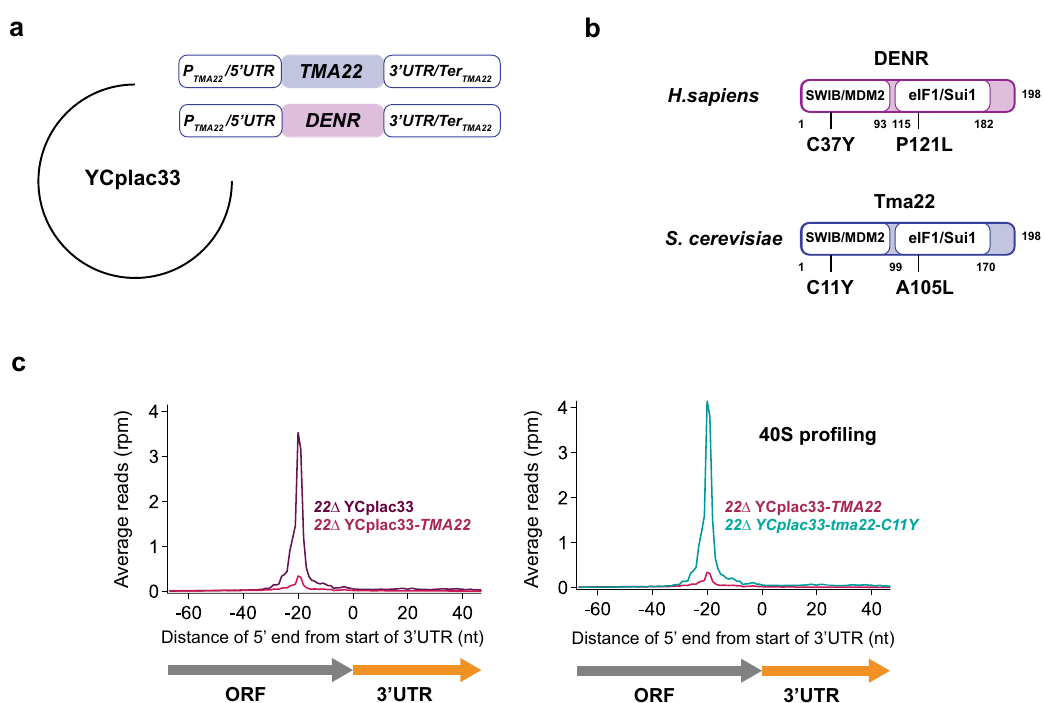
Fig. 7 Introduction of an autism-associated mutation into TMA22 impairs 40S recycling at stop codons. a Schematic diagrams of the constructs used to express S. cerevisiae TMA22 and H. sapiens DENR in yeast. The TMA22 gene along with its natural promoter 5 ′ UTR, 3 ′ UTR, and transcription termination sequences was cloned into the single-copy yeast vector YCplac33. To create a yeast DENR expression vector, the coding sequence of the TMA22 was replaced with DENR so that expression would be under the control of the TMA22 promoter. b Schematic representation of the H. sapiens DENR and S. cerevisiae Tma22 proteins showing homologous domains and the locations of ASD-associated mutations. c Average 40S ribosome footprint occupancy from all genes aligned by their stop codons shows complementation of the 40S recycling defect in tma22 Δ upon expression of WT TMA22 (left) and loss of recycling activity upon introduction of the C11Y mutation into TMA22 (right). Footprints plotted by 5 ′ ends. nt nucleotide, rpm reads per million. Source data are provided as a Source Data fi le. See also Supplementary Fig.